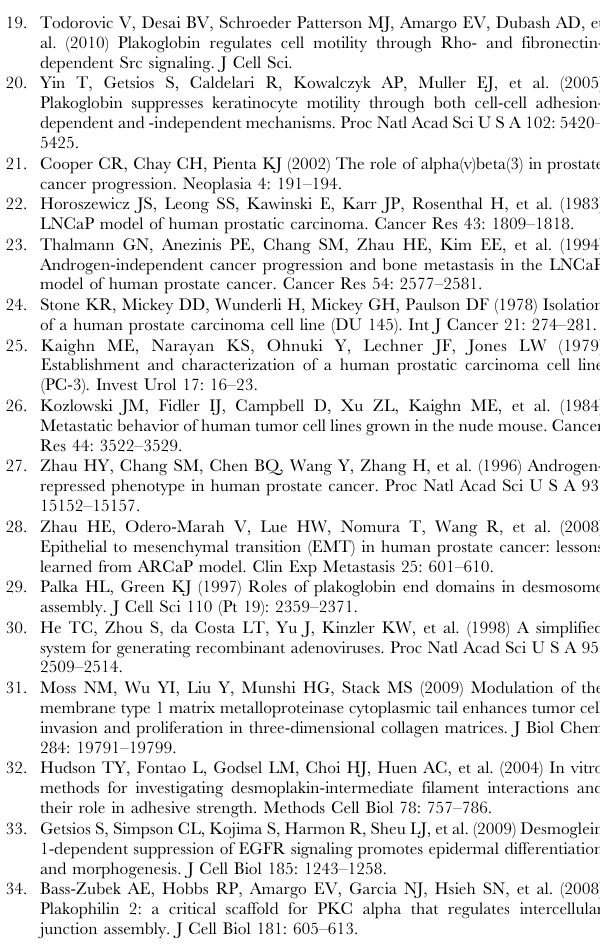
Figure S3 PG expression stabilizes adherens and des- mosomal junction components in PCa. A. Immunofluores- cence staining showing the localization of E-cadherin in LNCaP cells after PG overexpression. B. Western blots showing expression of adherens and desmosomal junction components after over- expression or knockdown of PG in ARCaP M and ARCaP E cells, respectively. Figure S4 PG-dependent Src activity is regulated by ECM composition. A. Western blot demonstrating